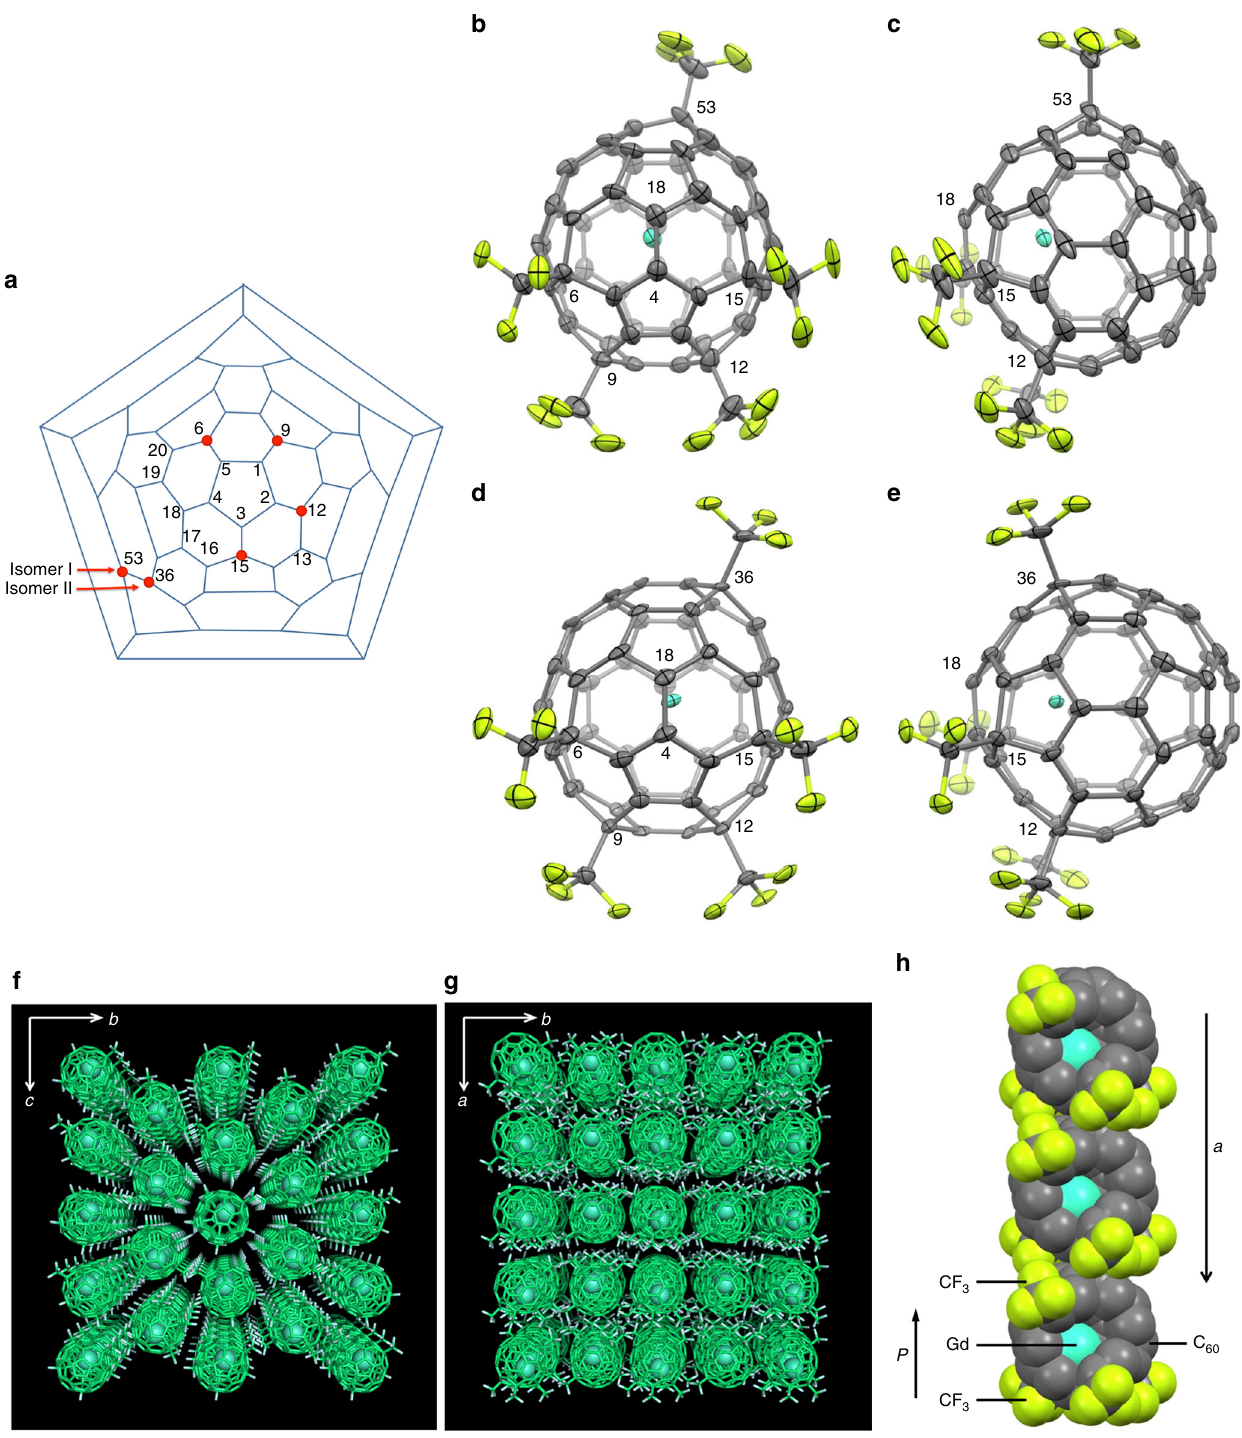
Fig. 1 Gd@C 60 (CF 3 ) 5 (I) and (II). a Schlegel diagram of C 60 . CF 3 groups attached to Gd@C 60 (CF 3 ) 5 (I) and (II) are shown as red circles. b , c Molecular structure of Gd@C 60 (CF 3 ) 5 (I). d , e Molecular structure of Gd@C 60 (CF 3 ) 5 (II). Front views facing the bond between carbon atoms 4 and 18 ( b , d ) and